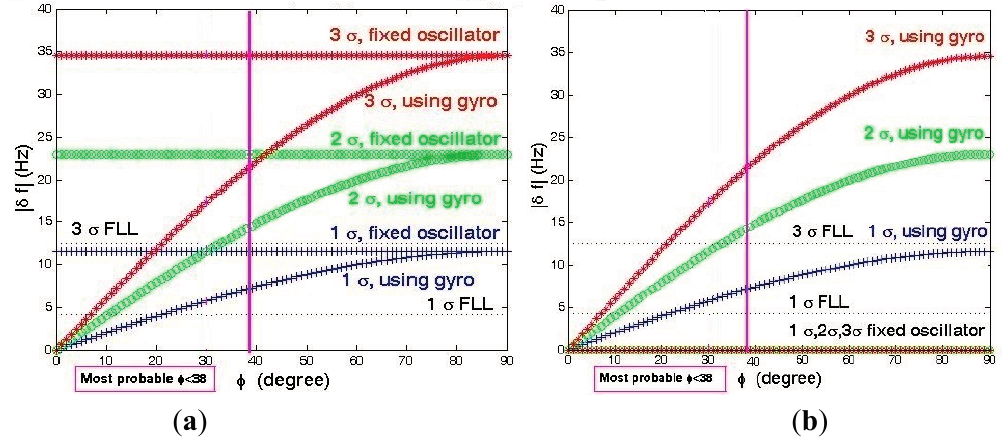
Figure 19. Analysis of FLL for receivers equipped with the gyroscopic mounting in different states. ( a ) Maximum effect state ξ = φ , β = 0; ( b ) Maximum drawback state, ξ – φ = 90° or β =